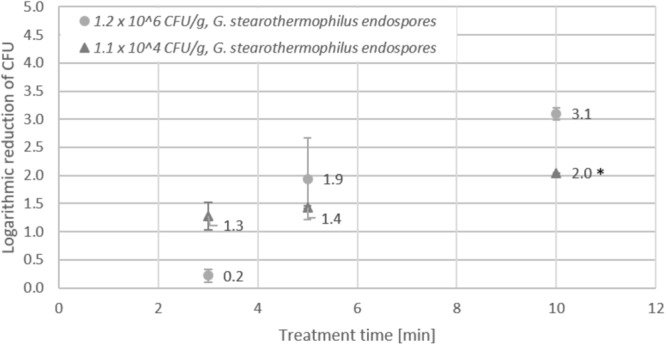
Effect of CAPP treatment of Geobacillus stearothermophilus endospores on lentil seeds. Inoculation was performed either as high initial inoculation (1.2 × 106 CFU/g) or low initial inoculation (1.1 × 104 CFU/g) prior to treatment of seeds for 3, 5, or 10 min in the DCSBD. Logarithmic reductions were represented as log10 CFU/g ± standard deviation. The limit of detection for endospores was 100 CFU/g. Logarithmic reduction below the limit of detection is indicated by an asterisk.